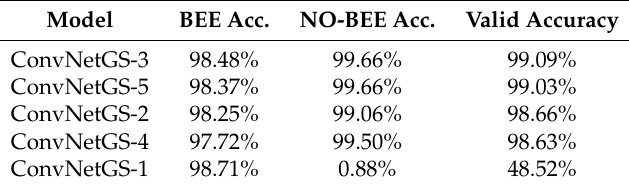
Table 2. Performance of best auto-designed ConvNet models on BEE1. Each network was trained for 50 epochs. The number following the model type (ConvNetGS—GS stands for greedy search) shows the number of hidden layers in each ConvNet. A hidden layer consists of a convolutional layer followed by a maxpooling layer. The validation accuracies are sorted from highest to lowest. The architecture of ConvNetGS-3 is given in Figure A1 in Appendix A. Model BEE Acc. NO-BEE Acc. Valid Accuracy ConvNetGS-3 98.48%